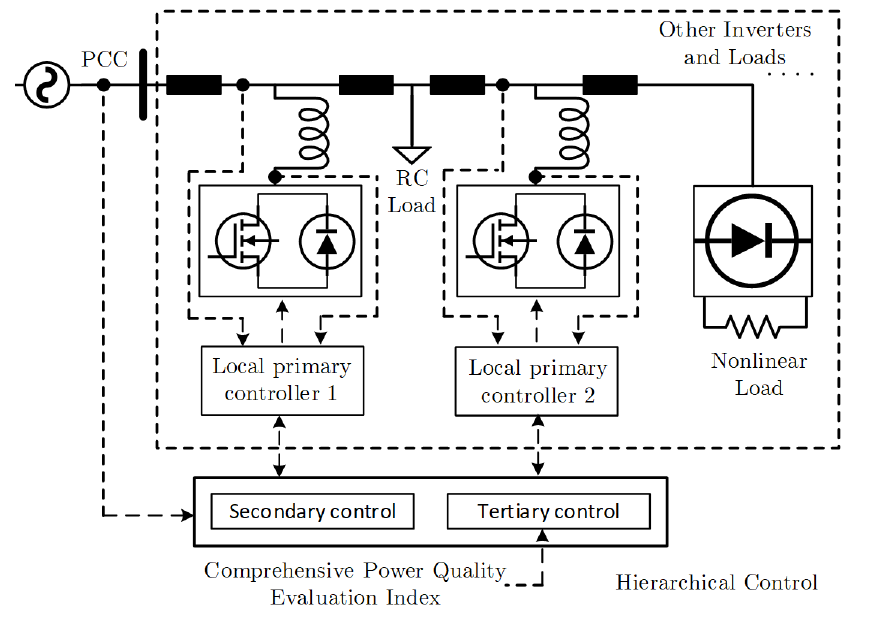
Figure 8. Multi-objective control on hierarchical-based micro-grid application [96].